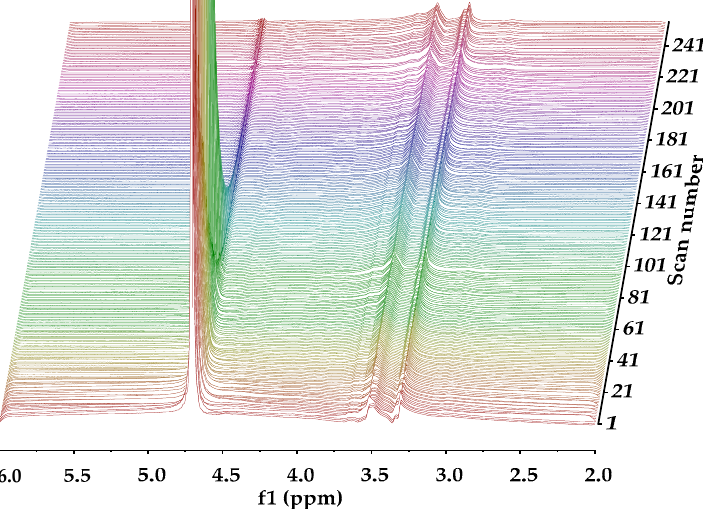
Figure 3. NMR DOSY experiment for the 0.5 mass % HEMC hydrogels: a series of NMR diffusion spectra with varying gradient strengths. Chemical shifts (in ppm) lie on the horizontal axis while magnetic gradient pulse amplitude is on the orthogonal axis, increasing with increasing scan number.